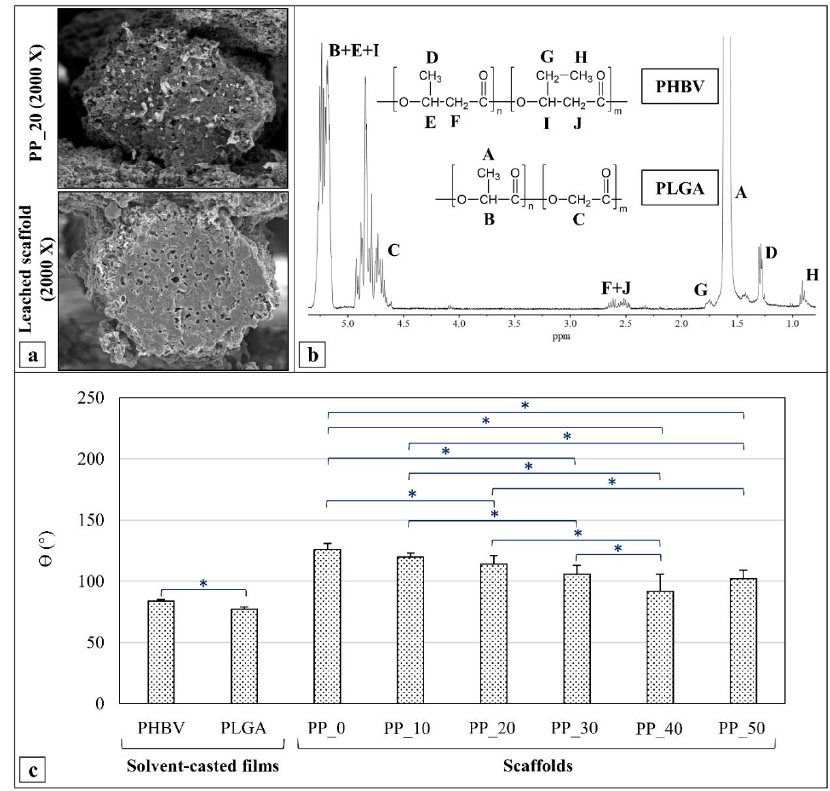
Figure 4. ( a ) SEM micrographs of the cross-section of a single PP_20 scaffold fiber before (top) and after (down) acetone leaching, demonstrating the presence of microholes in place of microfibrils, as